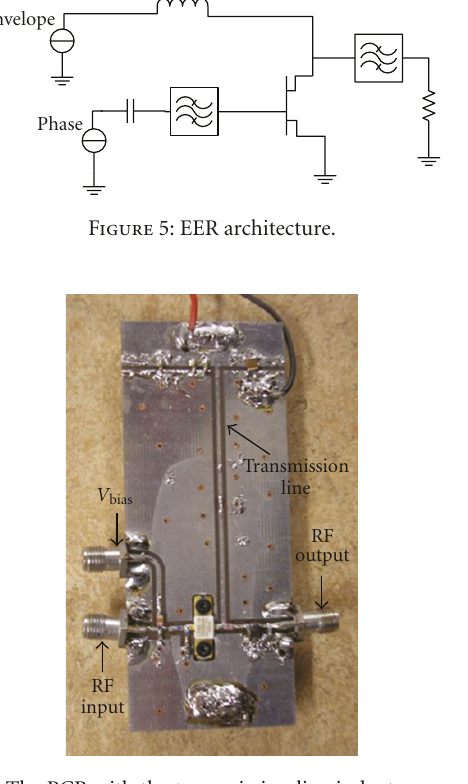
Figure 6: The PCB with the transmission line inductance and I/O ports indicated.